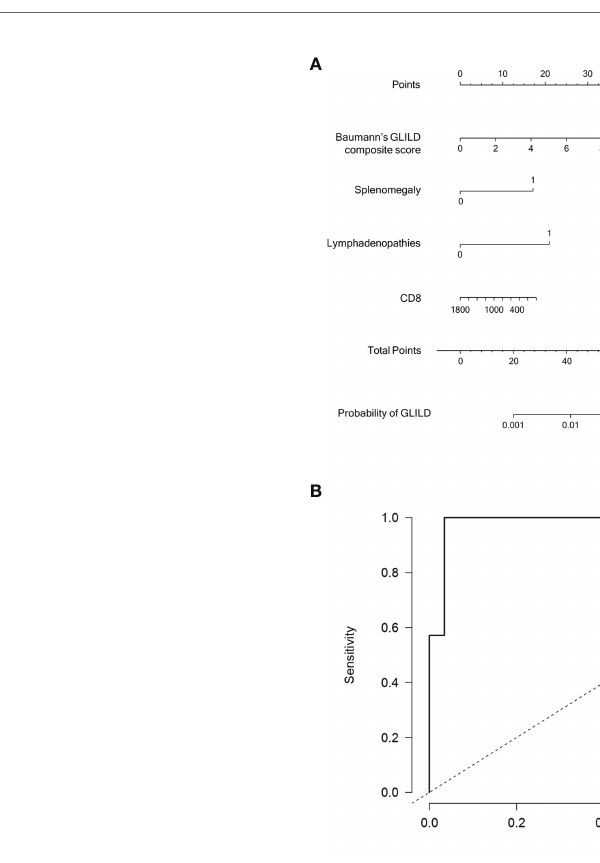
FIGURE 1 | (A) Nomogram predicting the probability of GLILD in CVID patients. (B) Receiver operating characteristic curve of the Bayesian regression model including Baumann ’ s composite GLILD score, splenomegaly, CD8 cell count, and generalized lymphadenopathies for the prediction of GLILD. To obtain the nomogram predicted probability of GLILD, locate the patient values for each of the four variables at their own variable axis. Draw a vertical line to the upper “ Point ” axis to determine how many points are attributed for each variable value. Sum the points for all variables. Locate the sum of the total points in the “ Total points ” line. Draw a vertical line towards the “ Probability of GLILD ” line to determine the estimated probability of GLILD (an example of the use of this nomogram is provided in Appendix S1 ). GLILD, granulomatous – lymphocytic interstitial lung disease; CVID, common variable immunode fi